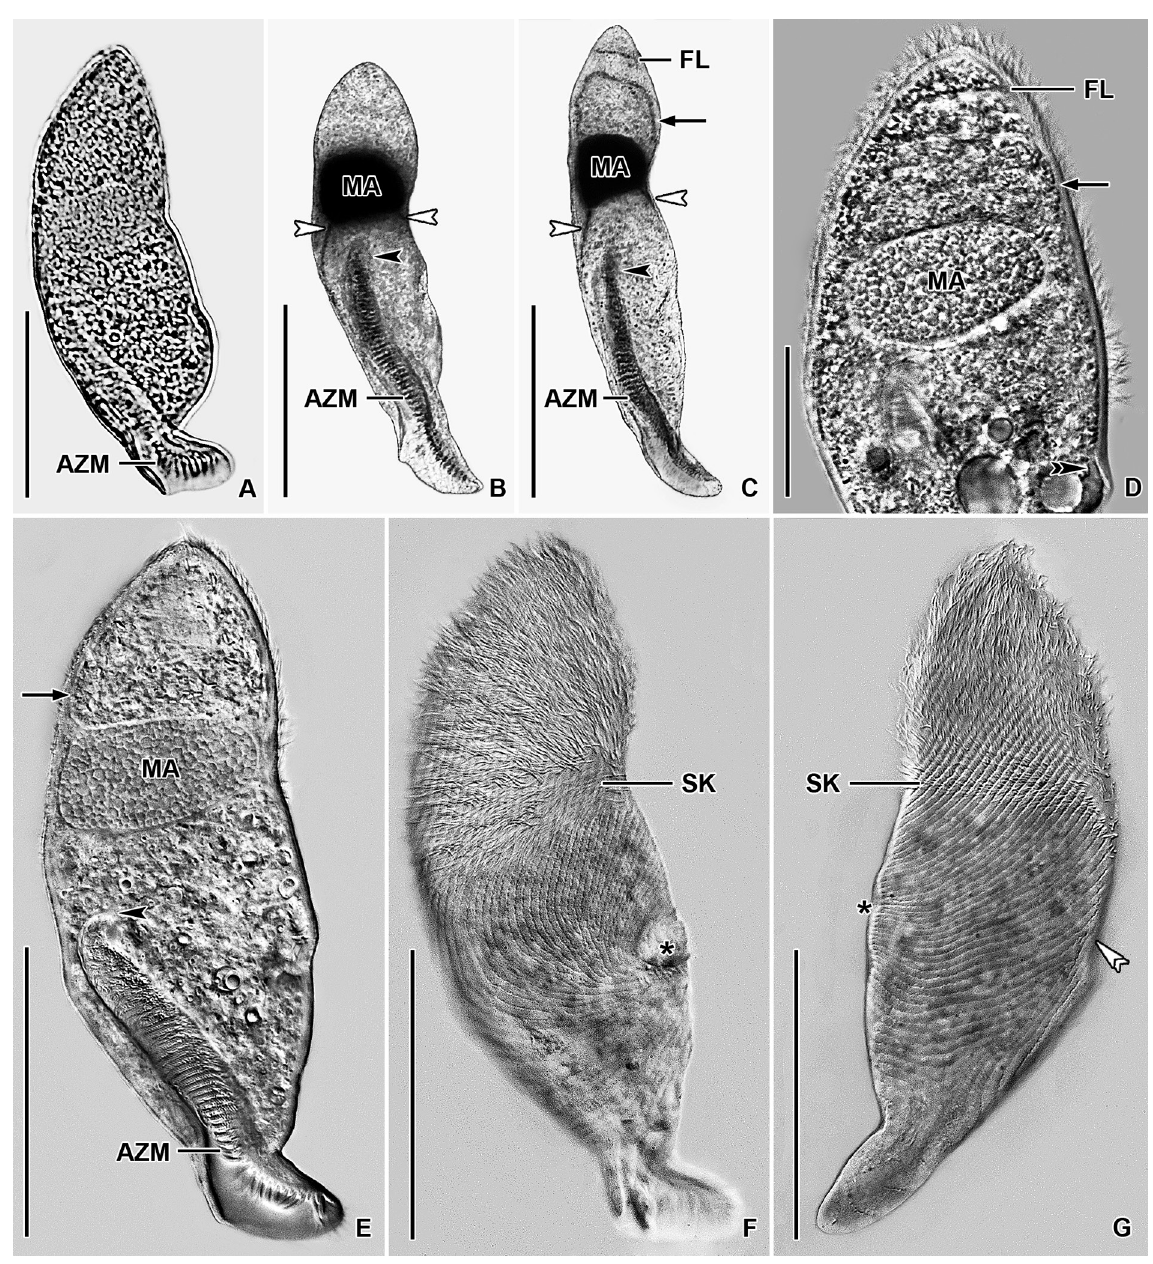
Fig. 3. Clevelandella constricta (Kidder, 1937). Vietnamese (a, E‒G) and Cambodian (D) specimens isolated from Panesthia angustipennis cognata Bey-Bienko, 1969, as well as Thai I specimens (B– C) isolated from Panesthia angustipennis angustipennis (Illiger, 1801) from life (a, D–G) and after protargol impregnation (B–C). A–C . Ventral view of specimens with well-preserved body shape. D–E . Ventral view, showing the general body organization. Arrows mark oval, refractile bodies anterior to the macronucleus, black arrowheads mark the proximal end of the adoral zone of membranelles, white arrowheads denote the karyophore attached to the right and left body margins and black double arrowhead marks the canal leading from the contractile vacuole to the cytopyge. F–G . Ciliary pattern of ventral and dorsal sides. Asterisks mark the position of the ciliary whorl (posterior suture), white double arrowhead denotes the right suture. Scale bars: a–C, E–G = 50 μm; D = 20